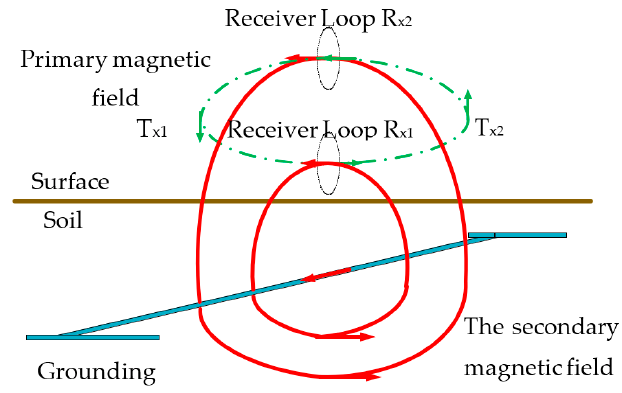
Figure 2. Detection process of the secondary magnetic field.